Question: State the chart type depicted above.
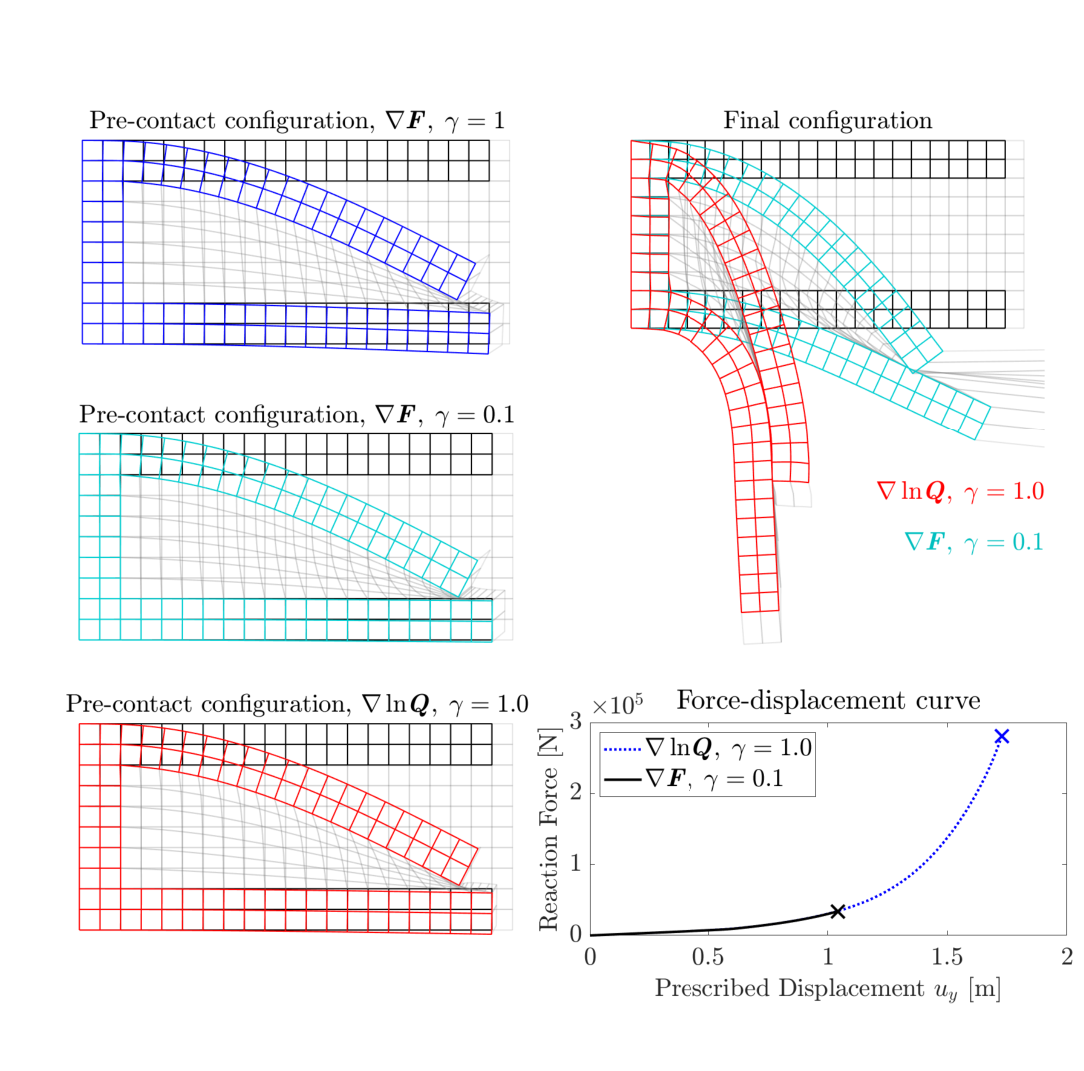
Answer: line